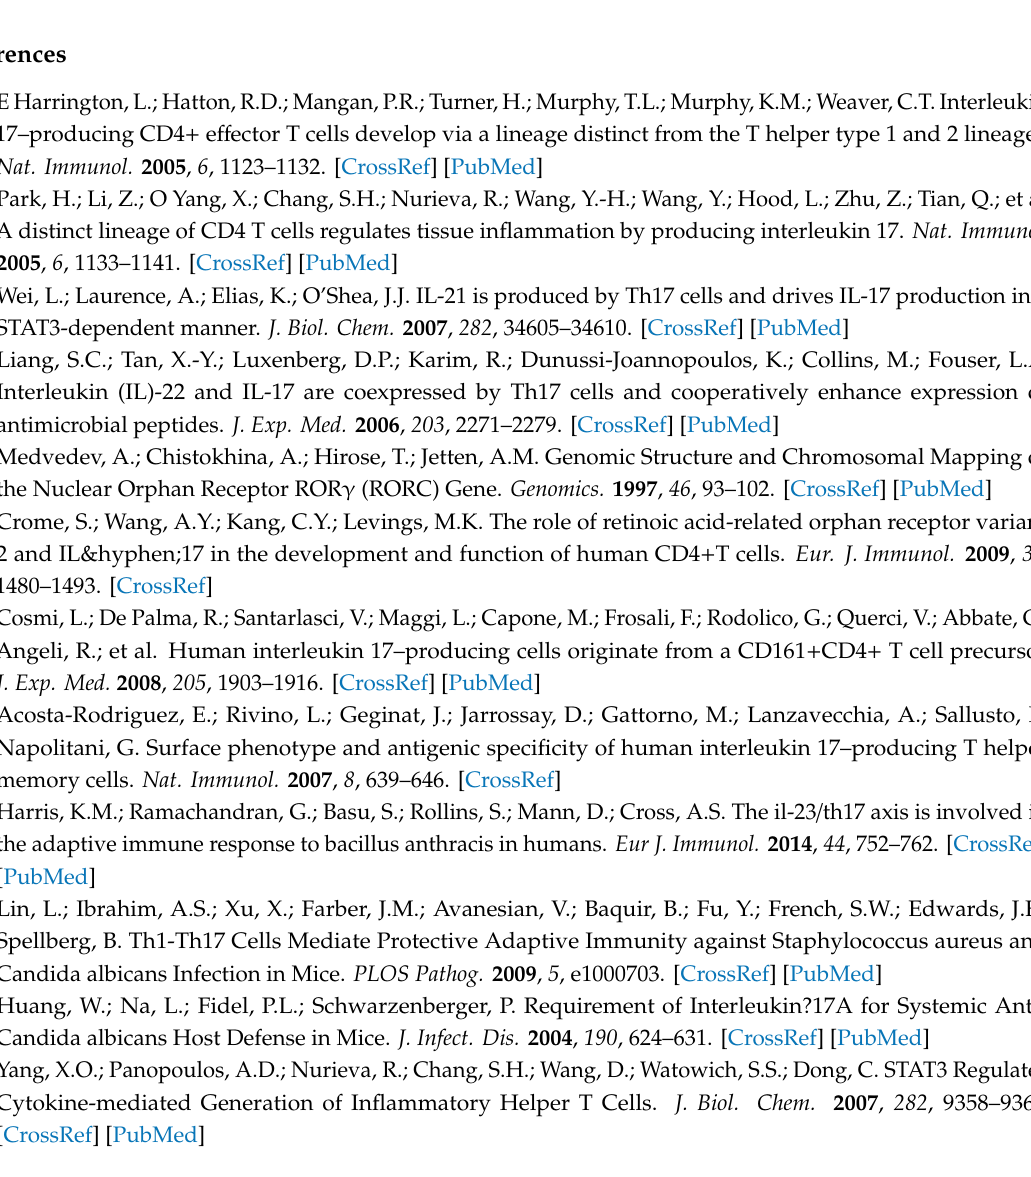
Figure S1: mRNA expression of TBX21 (A), GATA3 (B),ROR γ T (C), and FOXP3 (D), signature transcription factor genes in Th1, Th2, Th17, and Treg cells, respectively. Figure S2: Results of IL-2 (A), IL-4 (B), IL-17 (C), and CTLA4 (D) production determined using ELISA. Table S1: Results of gene ontology (biological process) term analysis with the PANTHER overrepresentation test for significantly di ff erentially expressed (DE) genes whose expression in CD4 + cells changed during di ff erentiation towards a Th17 phenotype.Table S2: Results of initial screening for putative Th17-specific genes.DataSet S1. DataSet